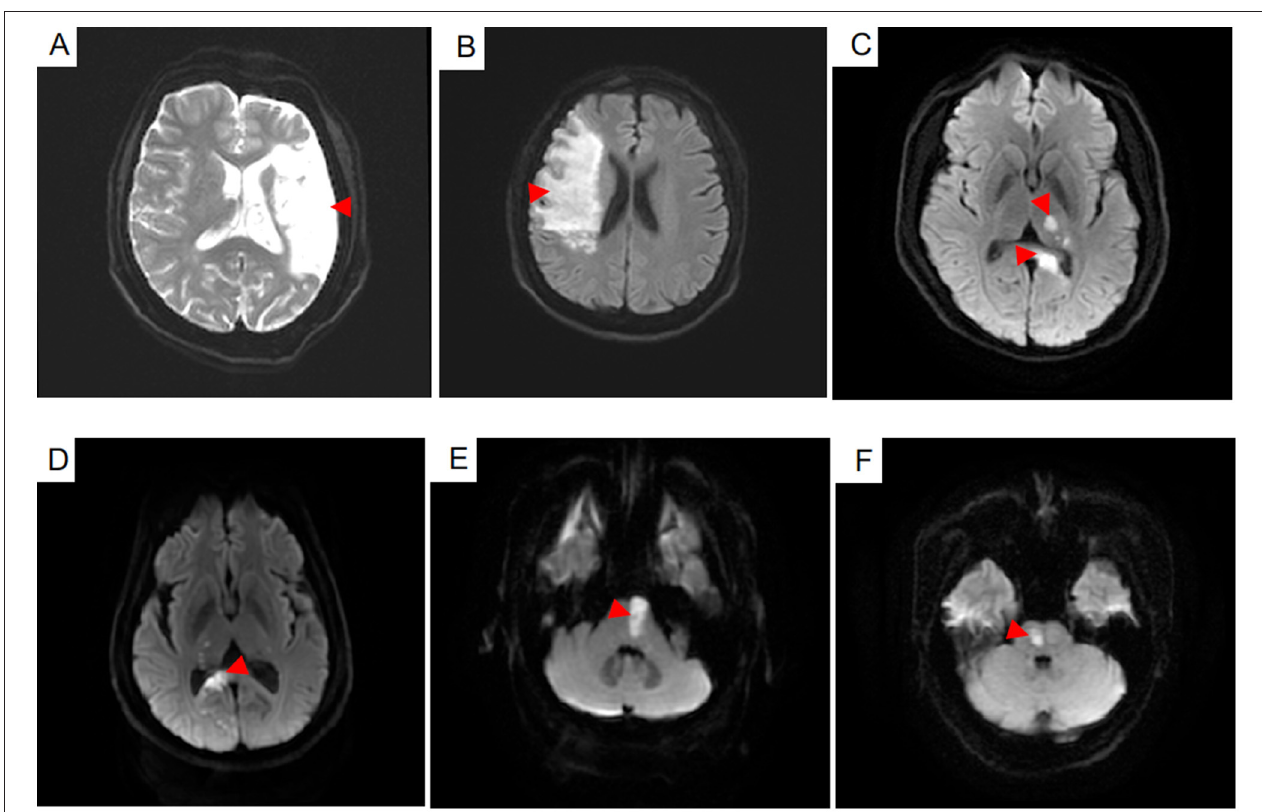
FIGURE 2 | The infarct lesions of six patients in the different cerebral artery regions were shown on the diffusion weighted imaging sequence (A–F) . Infarct lesions in the middle cerebral artery the regions including the upper lateral surface of the cerebral hemisphere and the insular lobe were showed in the (A,B) . Infarct lesions in the posterior cerebral artery regions including the thalamus, par hippocampal gyrus, inferior temporal gyrus and lingual gyrus were shown in the (C,D) . Infarct lesions in the basilar artery regions including the pons and medulla were shown in the (E,F)